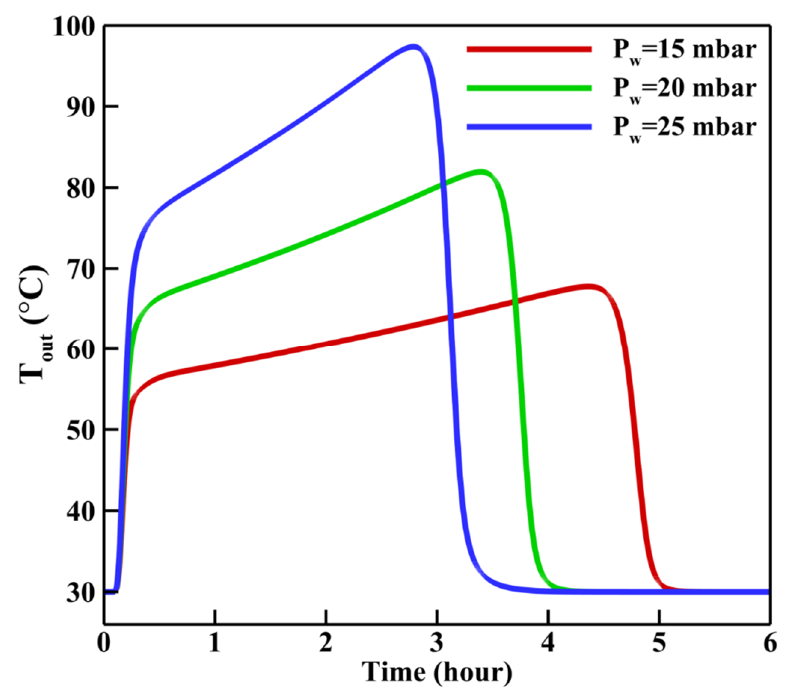
Figure 5. Variation of outlet temperature under different p w , in . To study the influence of the mass flow rate (MFR) of the incoming air on the dis- charging process, three different values—1, 1.5, and 2 kg h⁄ —are considered for mass flow rate and the variations of discharging time, outlet temperature, and released adsorption enthalpy are calculated.